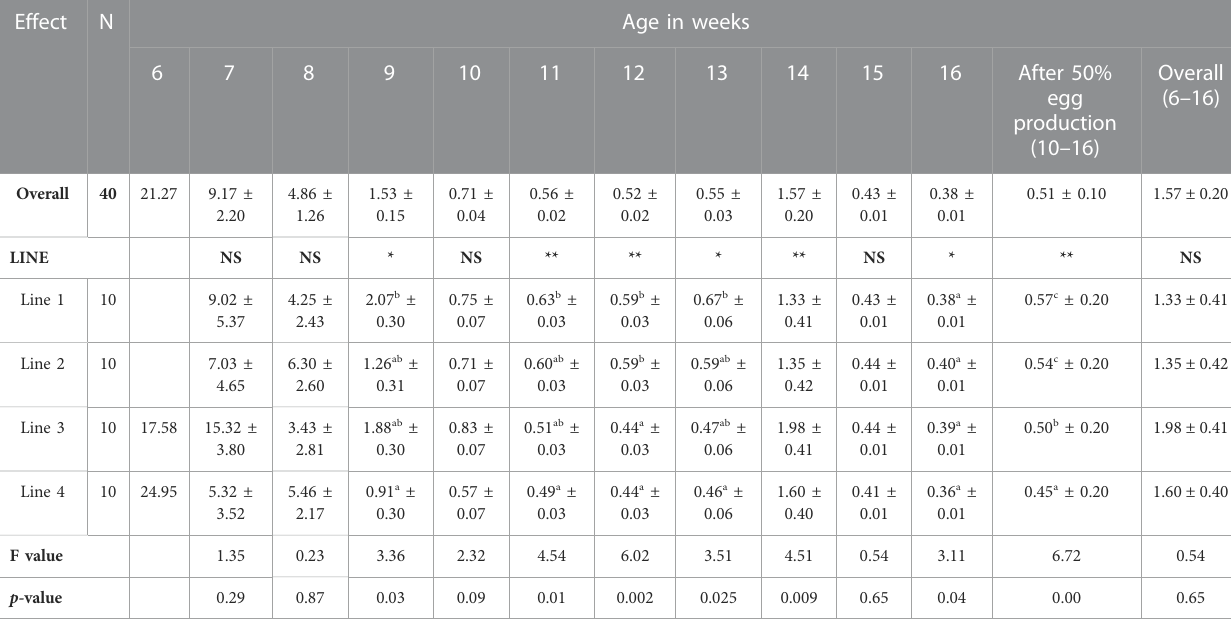
TABLE 9 Means (±S.E.) of weekly feed ef fi ciency/dozen eggs of different lines of Japanese quails from 6th to 16th week of age. Effect